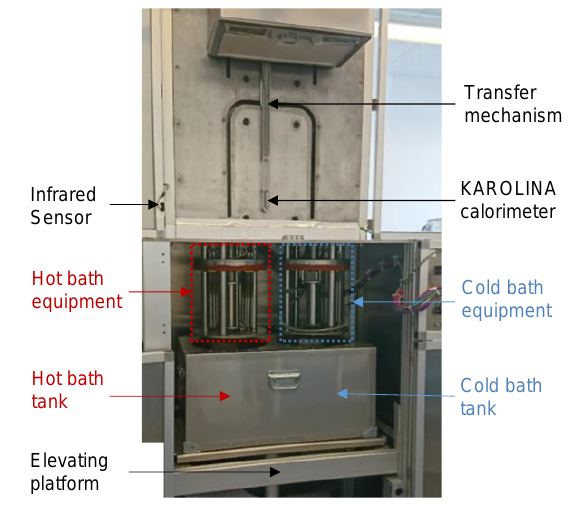
Fig. 4 Picture of calibration bench BERTRAN.